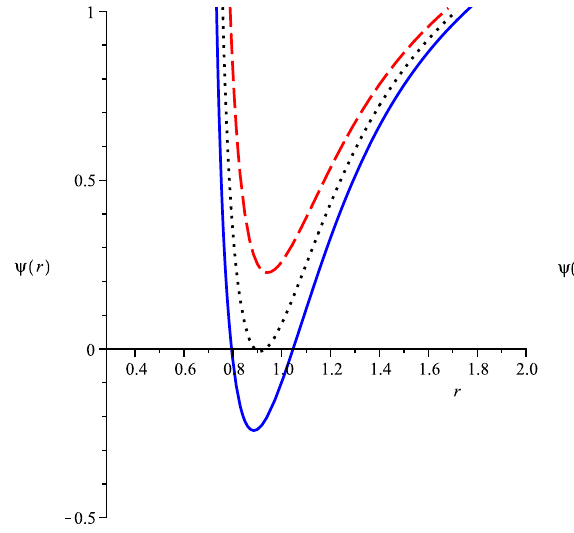
c 2 = − 3, c 3 = 4, c 4 = − 2 (long-dashed line), c 4 = − 1 . 65 (dash- dotted line), c 4 = − 1 . 5 (thin-solid line), c 4 = − 1 . 02 (dotted line), c 4 = 4 . 4 (bold-solid line) and , c 4 = 7 (dashed